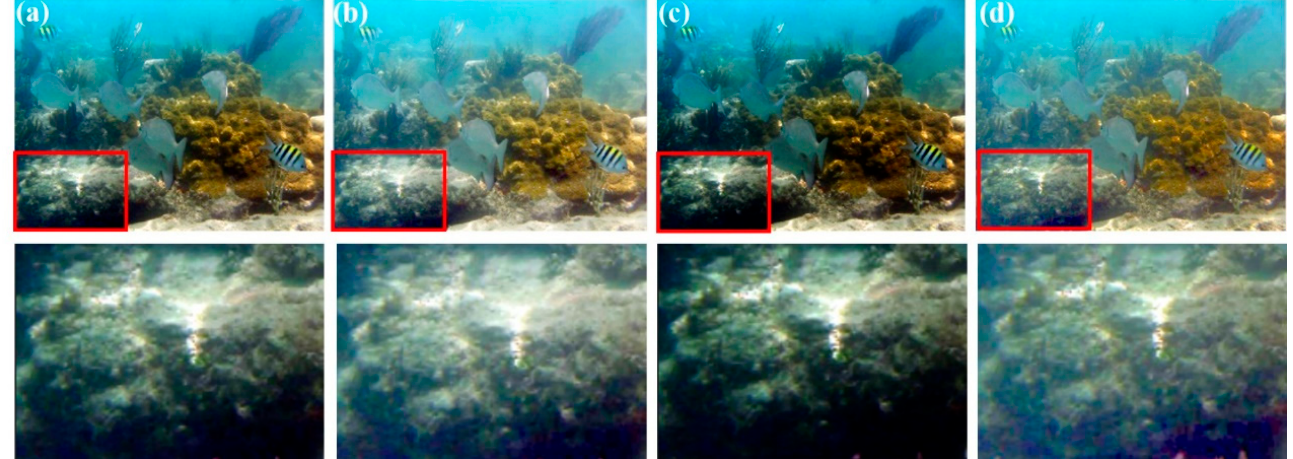
Figure 3. ( a ) Initial image, ( b ) γ = 0.7 , ( c ) γ = 1.3 , and ( d ) our method. From the gray histogram (see Figure 4), compared with the global contrast correction, the improved method considers the suppression of extremely bright areas and enhancement of extremely dark areas. As a result, more pixels are concentrated in the middle area.